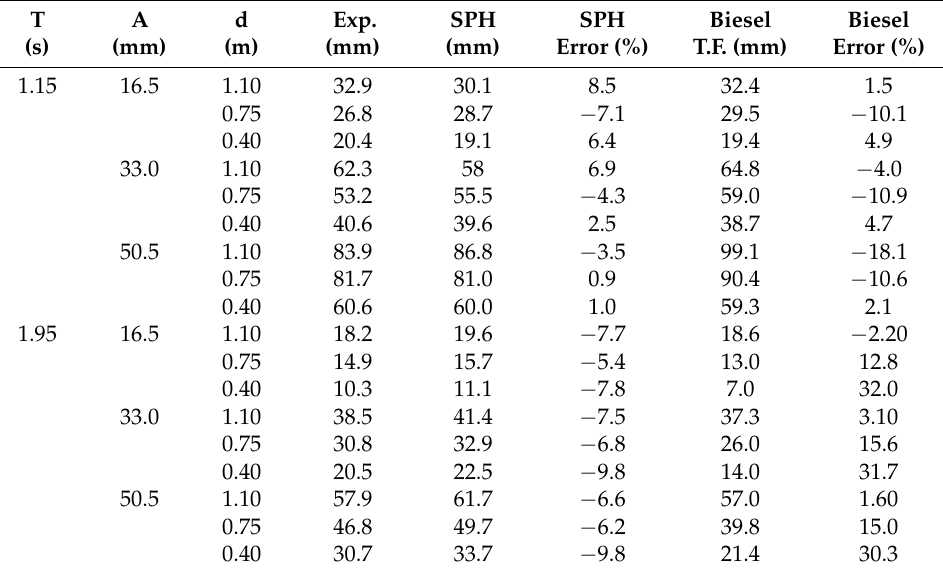
Table 6. Comparison of steady amplitude with a different method.